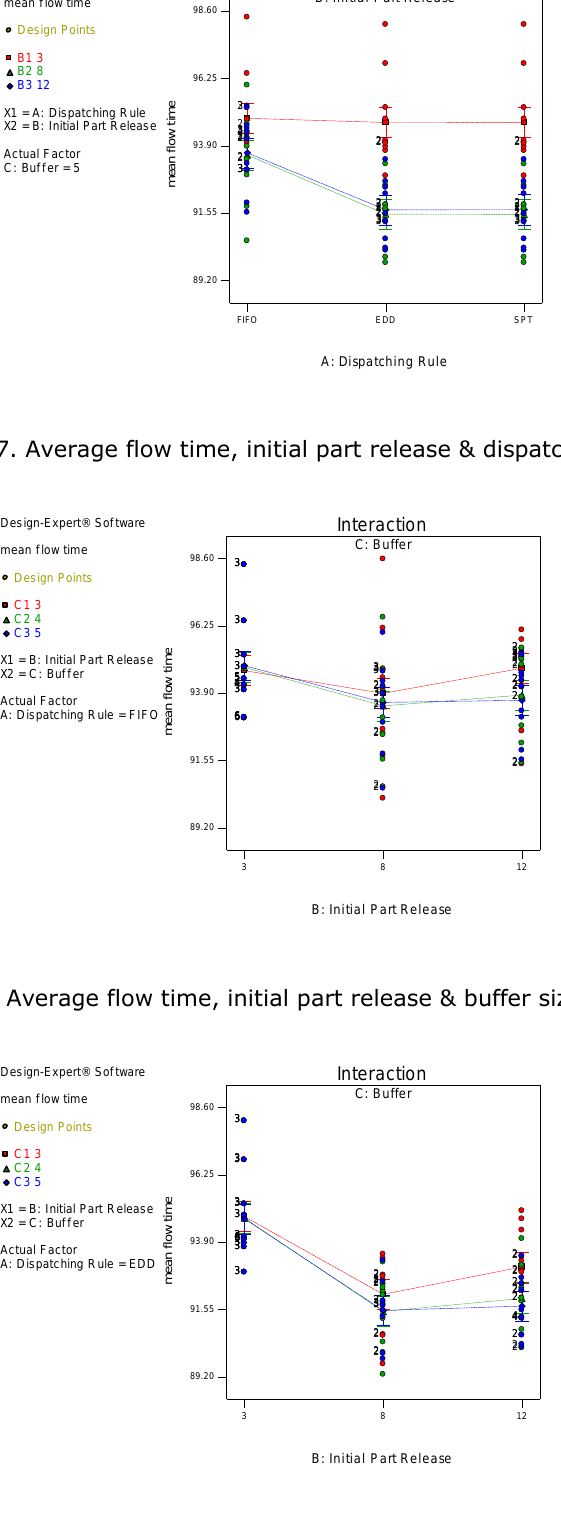
Figure 9. Average flow time, initial part release & buffer size for